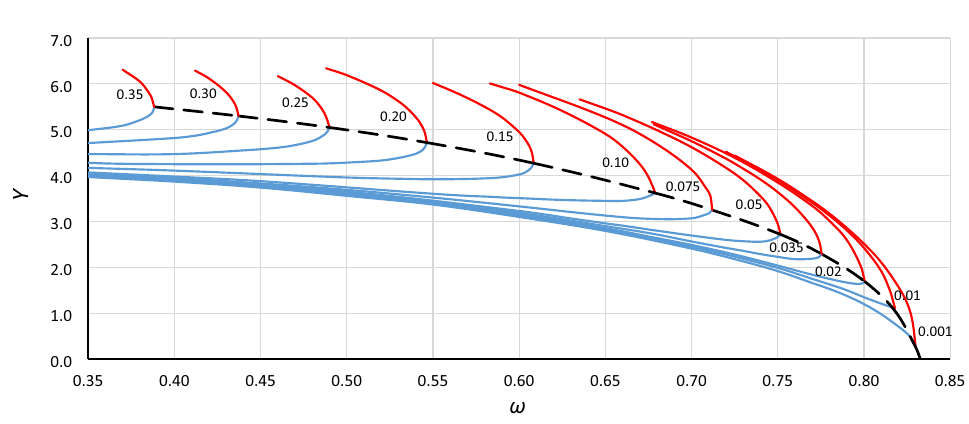
Figure 9. Curve of the origin point P B for case B3 ( α = 0.69336, β = − 0.015, ε = − 0.045) determined as a curve of convergence points of line L 1 (blue lines) and the upper limit of the bistability area for resonant oscillations (red lines), calculated for different values of damping coefficient η (from 0.001 to